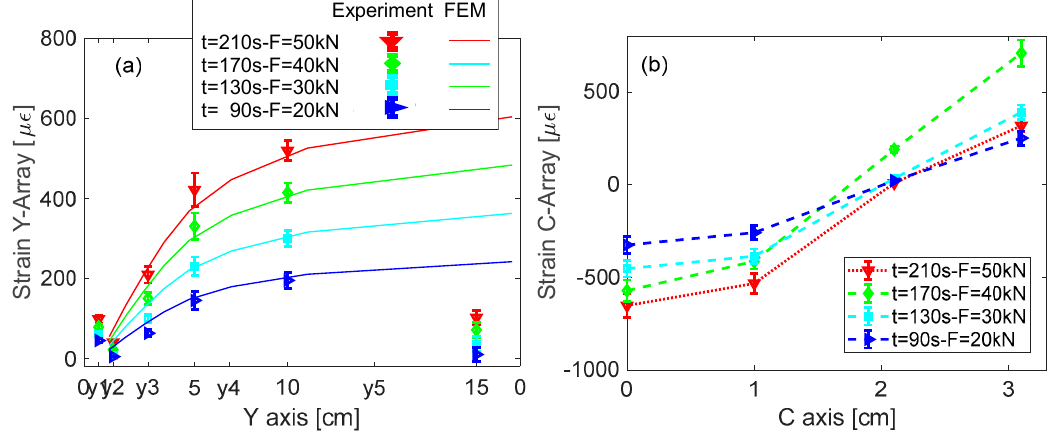
Figure 11. FBG Surface strain profile in different strain states: ( a ) Y-array; and ( b ) C-array.